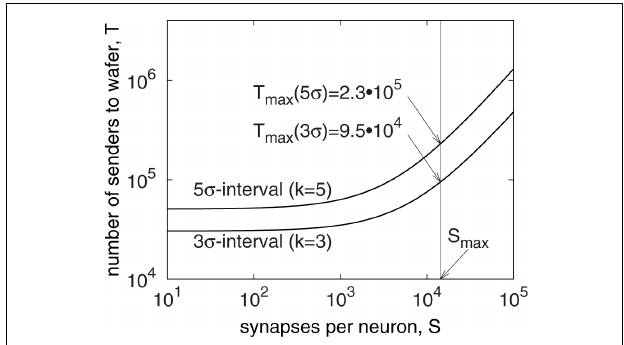
FIGURE 4 | Number of external spike sources for a fully utilized wafer with Gaussian (local)